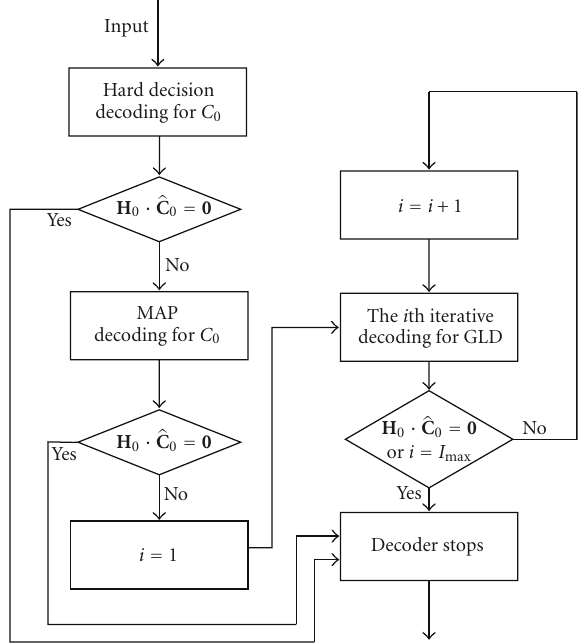
Figure 3: Flow chart of progressive decoding for relay nodes.